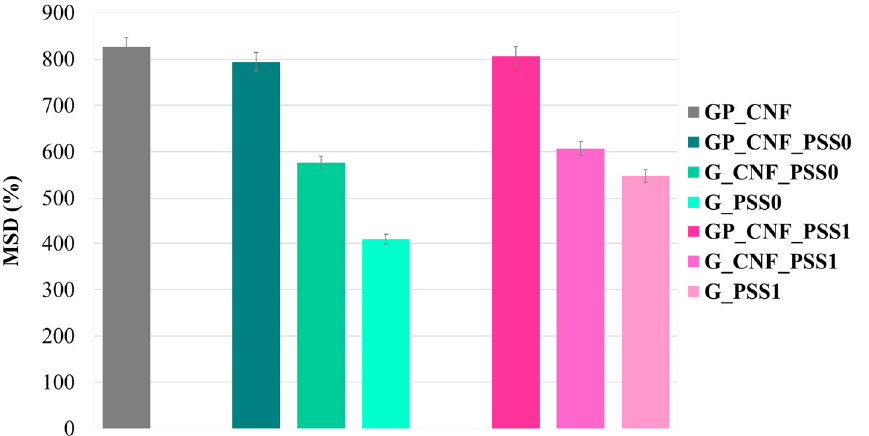
Figure 4. Maximum swelling degree (MSD) of the nanocomposite hydrogels presented comparatively depending on POSS functionalization.